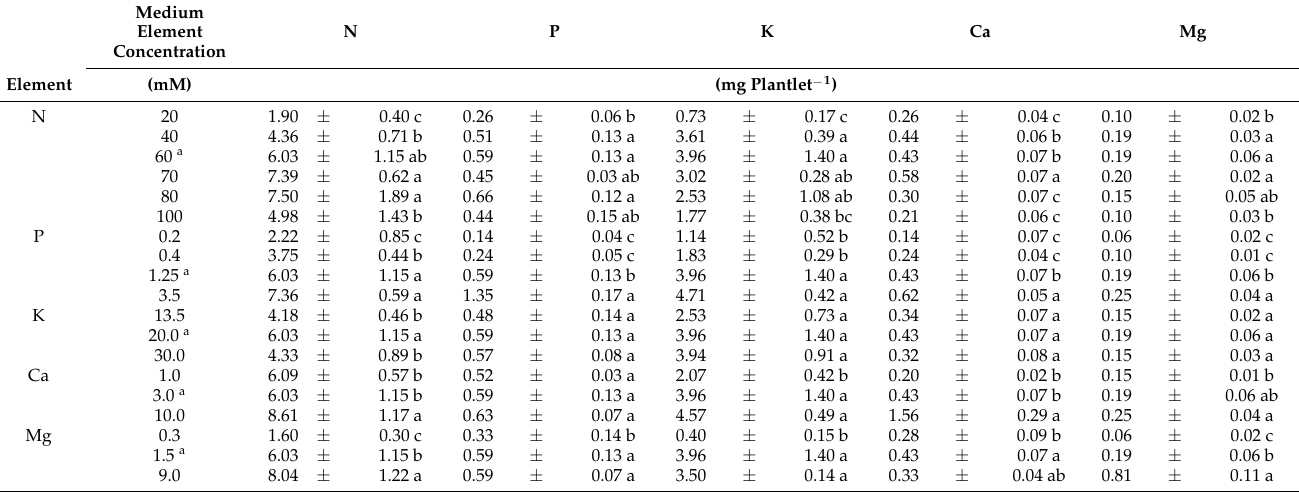
Figure 2. Photographs showing the morphological characteristics of potato plantlets supplied with varying concentrations (mM) of ( A ) nitrogen (N: 16 = deficient, 20–40 = insufficient, 60–80 = optimum, 100 = toxic); ( B ) phosphorus (P: 0.2 = deficient, 0.4 = insufficient, 1.25 = optimum, 3.5 = excessive); ( C ) potassium (K: 12.5 = deficient, 13.5 = insufficient, 20 = optimum, 30 = excessive); ( D ) calcium (Ca: 1.0–3.0 = insufficient, 10.0 = excessive); and ( E ) magnesium (Mg: 0.3–1.2 = deficient, 1.5 = optimum, 9.0 = excessive) < 0.05. Table 2. Effect of changes in nutrient element concentrations in MS medium on nutrient uptake in shoots of potato plants in